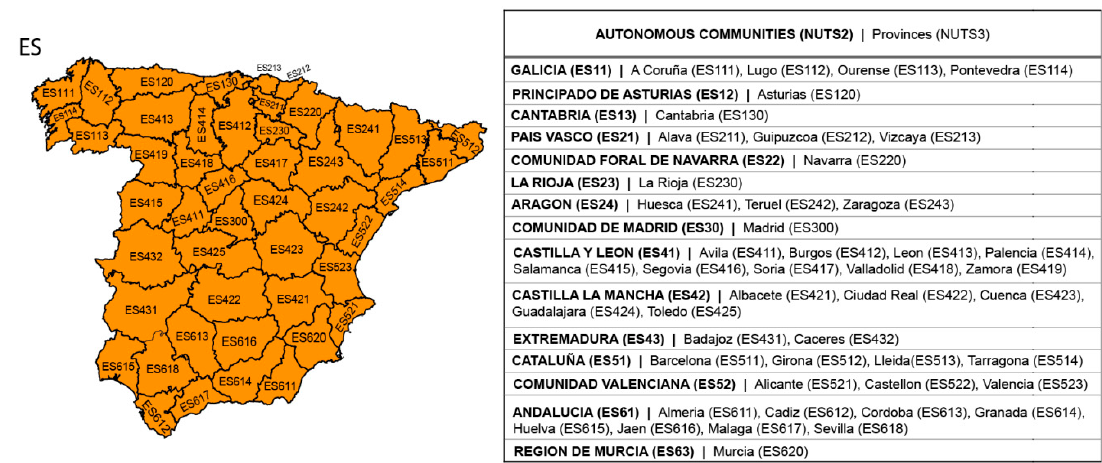
Figure 1. Subdivision of peninsular Spain according to the European Nomenclature of Territorial Units for Statistics (NUTS). The provincial and Autonomous Communities used correspond to levels 2 (NUTS2) and 3 (NUTS3), respectively. The NUTS3 provinces are shown on the map, with their names and the names of the corresponding NUTS2Autonomous Communities listed in the box on the right. ES=NUTS code of Spain.